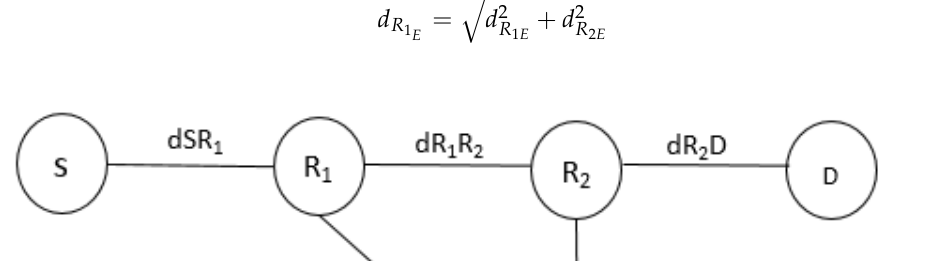
Figure 6. Illustration of PS EH Simulation.